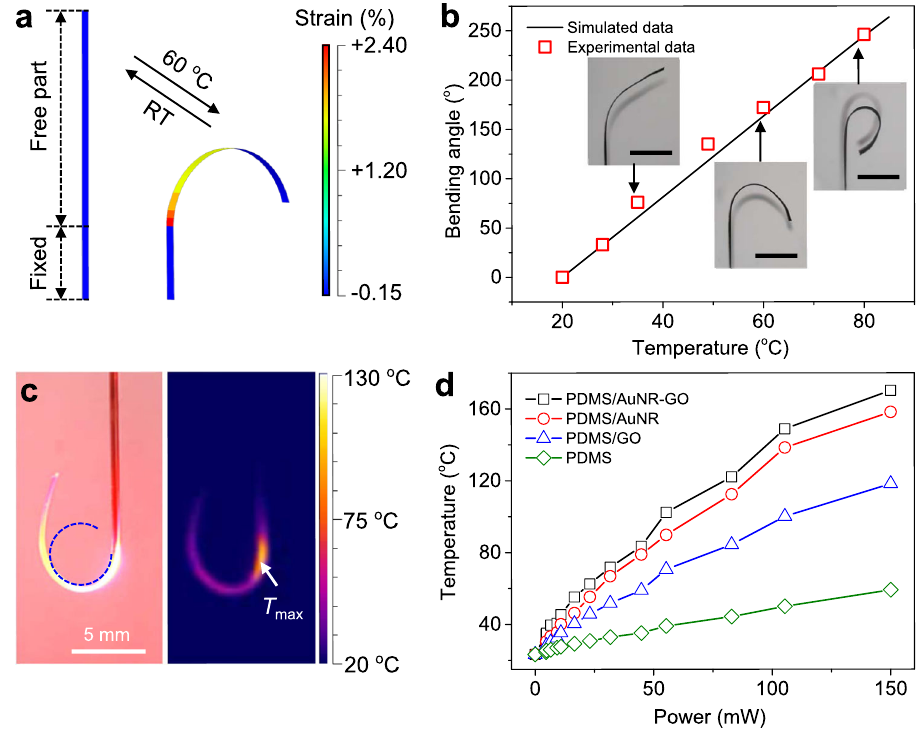
Fig. 2 Deformation and photothermal heating of OPA. a Finite element analysis of the OPA model (10 × 0.5 × 0.07 mm 3 ) by applying homogeneous temperature on the structure. b Simulated and experimental thermal bending angles of the OPA (10 × 0.5 × 0.07 mm 3 ) under different temperature. Scale bar: 5 mm. Source data are provided as a Source Data fi le. c Photograph (left) and infrared thermography image (right) of the OPA under 635 nm laser of 75 mW. The blue dotted line helps to show a diminishing bending curvature along the longitudinal direction of the OPA. d Measured T max of the OPA with various components as a function of the laser power. Source data are provided as a Source Data fi le.